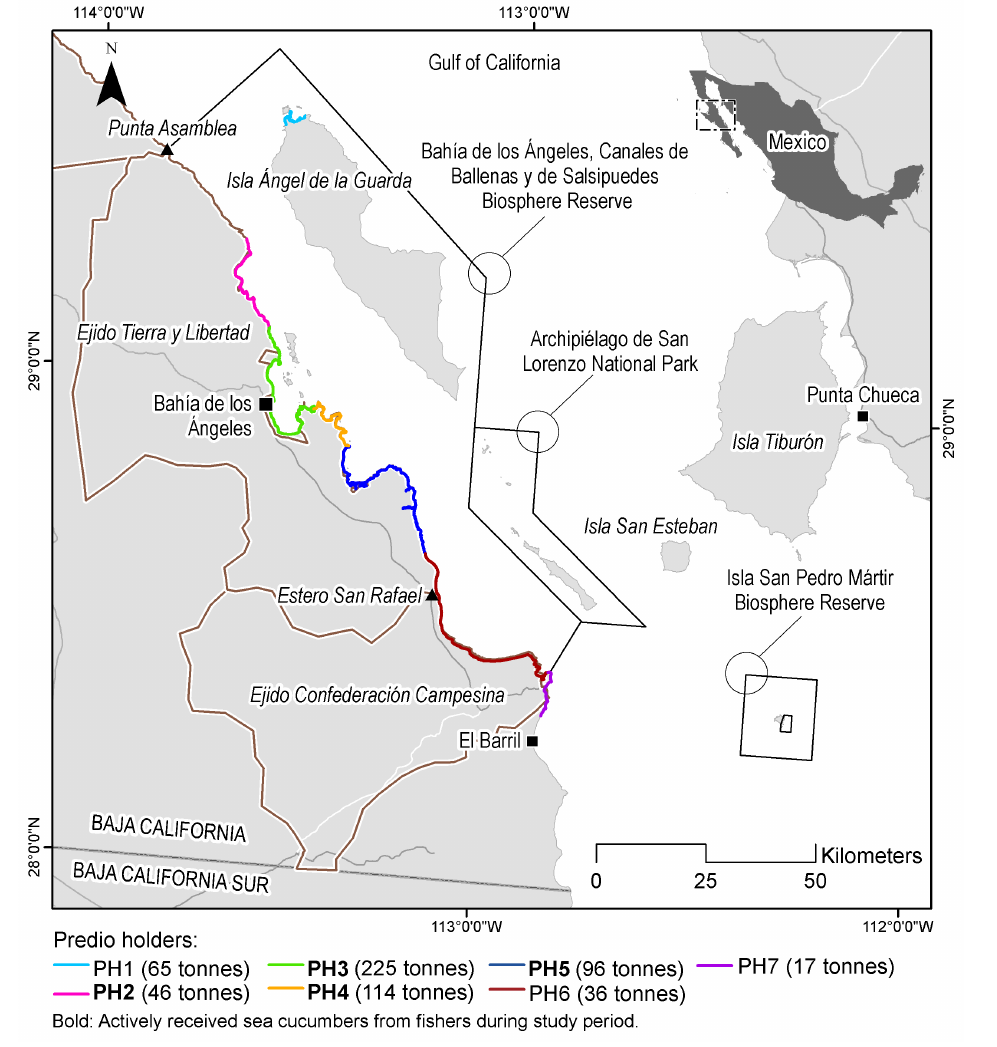
Fig. 4 . Coastal extension of predios (complete polygon coordinates were unavailable) granted inside the Bahía de los Ángeles, Canales de Ballenas y de Salsipuedes Biosphere Reserve from late 2007 to late 2008, and the corresponding quotas in tonnes per predio